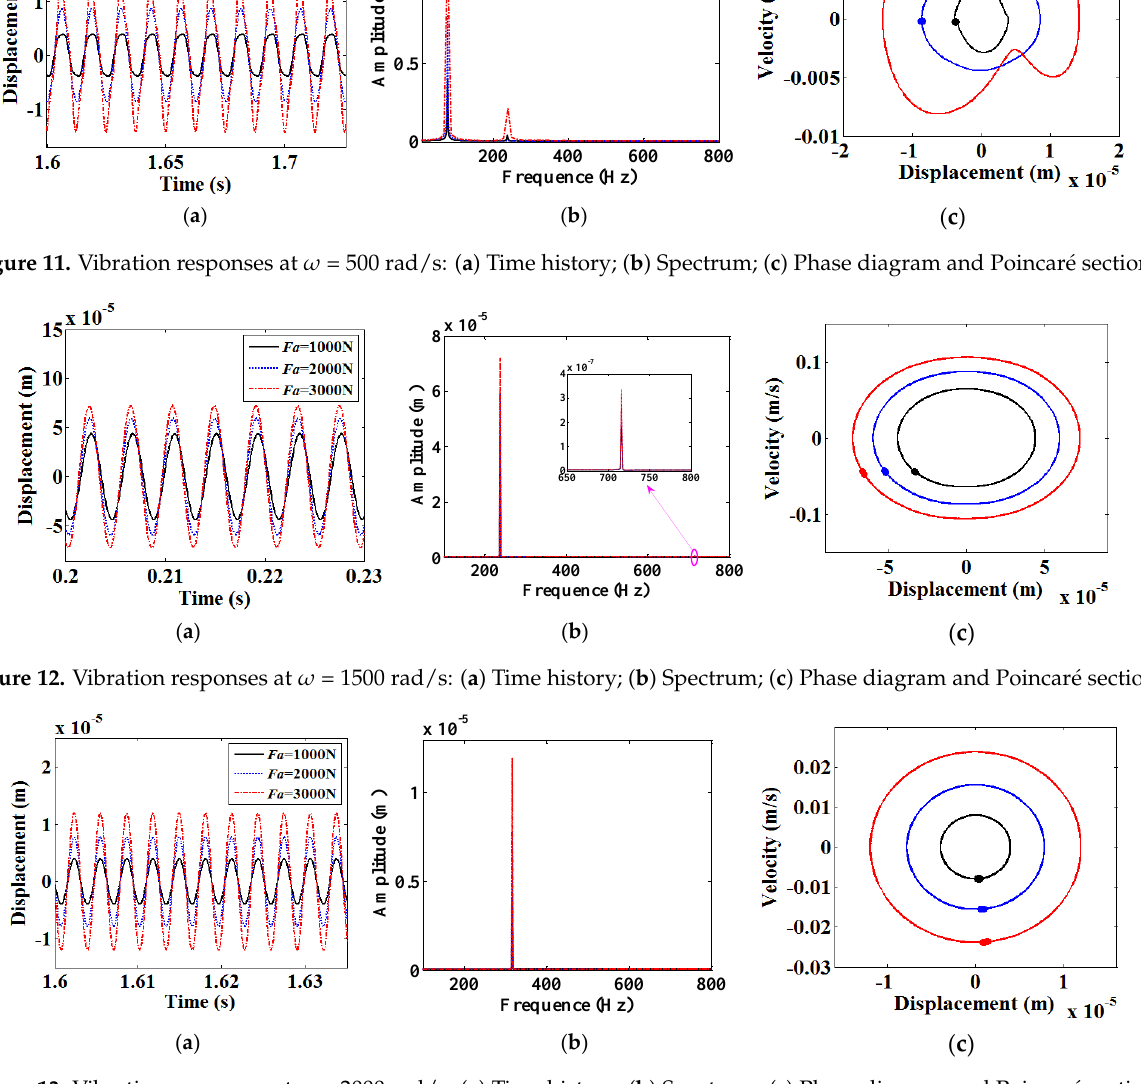
Figure 13. Vibration responses at ω = 2000 rad/s: ( a ) Time history; ( b ) Spectrum; ( c ) Phase diagram and Poincaré section.